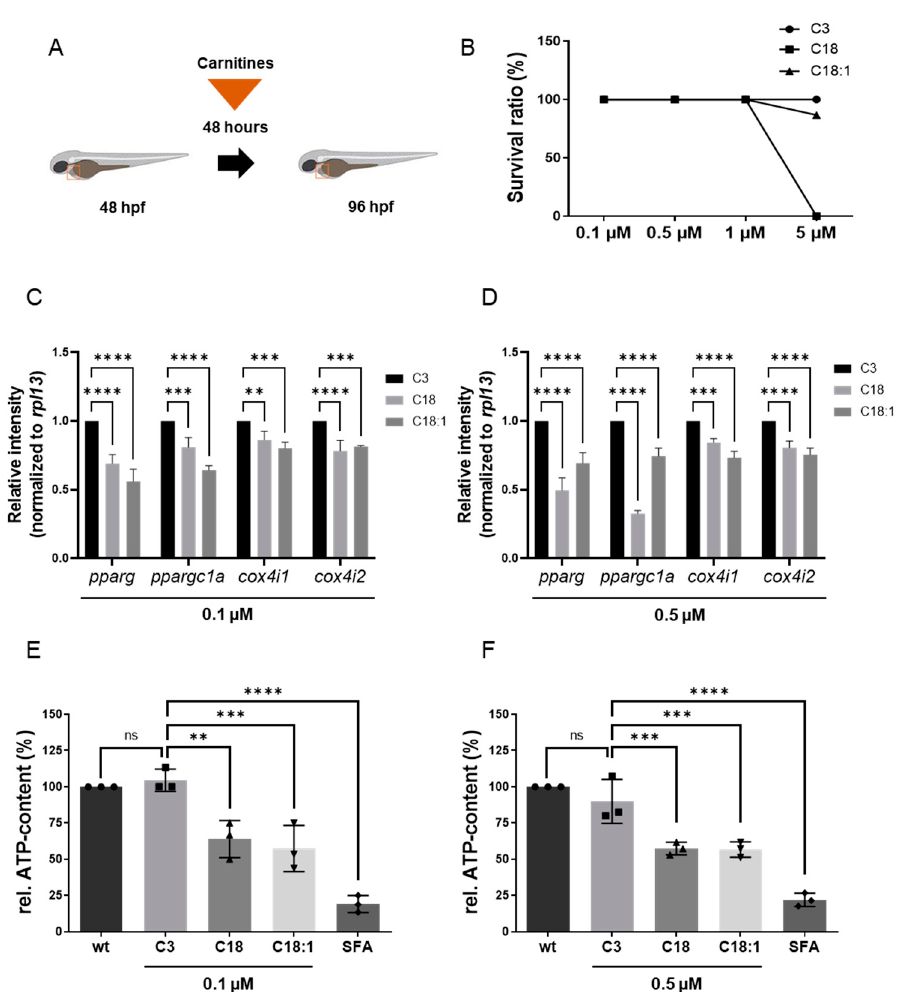
Figure 2. Experimental design of LCAC treatments in zebrafish embryos and survival rates for different concentrations of LCACs. Interrupted mitochondrial function by LCACs is accompanied by decreased ATP production. ( A ) Experimental design of compound treatments. ( B ) Lethality of the compounds at different concentrations. ( C , D ) Quantitative real-time PCR targeting genes related to ATP production (SD, n = 3, ns: p > 0.05, ** p < 0.01, *** p < 0.001, **** p < 0.0001). ( E , F ) Assessment of relative ATP content in zebrafish embryos after compound treatments (SD, n = 3, ns: p > 0.05, ** p < 0.01, *** p < 0.001, **** p < 0.0001). Abbreviations: rel. = relative, ns = not significant, wt = wild-type, SFA = sodium fluoroacetate.